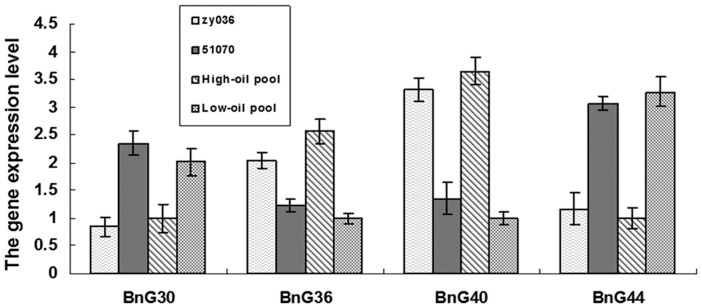
Real-time PCR analysis of the four candidate genes.Data expression was normalized to rapeseed Bnactin, and expression levels of four candidate genes (BnG30, BnG36, BnG40 and BnG44) in rapeseed siliques (15 DAF) in zy036, 51070, and two pools of individuals in the DH population with high and low seed oil contents were compared with that of Bnactin. Data presented are mean values of three biological replicates, and error bars represent standard deviations.